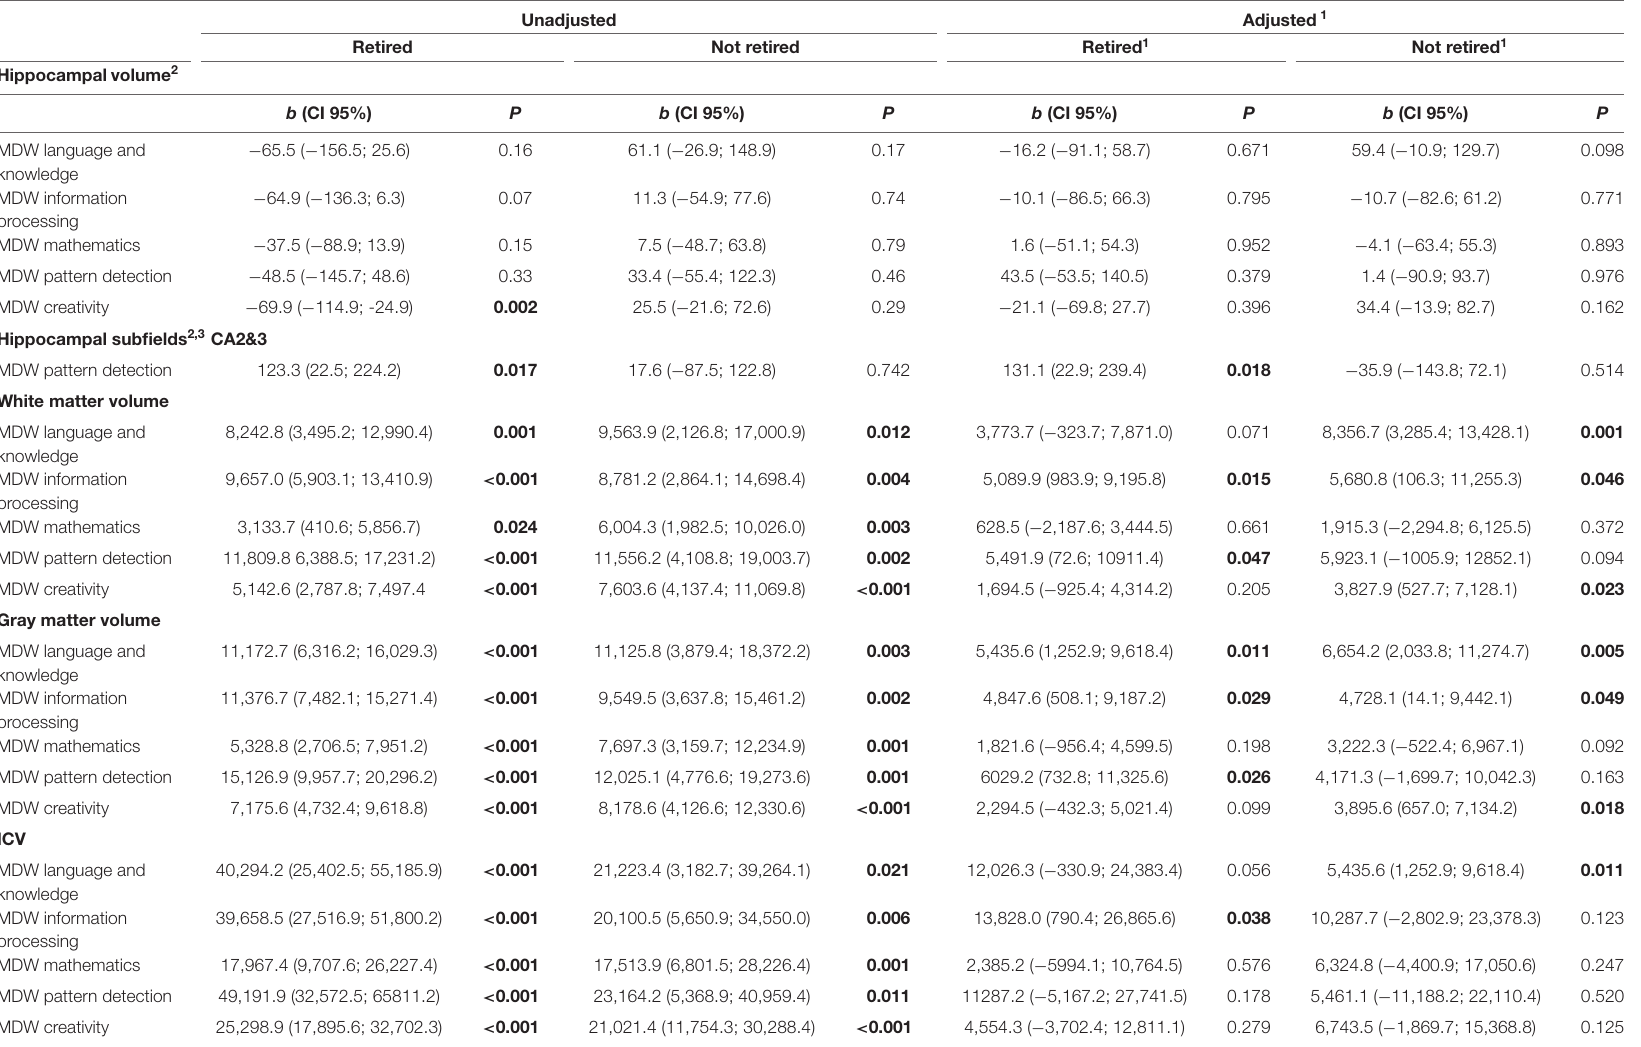
TABLE 4 | Results of the regression analyses on the association between MDW and hippocampal and brain volume, separate for those that are retired and those that are not retired, adjusted for age, gender, education, APOE e4-allele, hypertension, and diabetes. Unadjusted Adjusted 1 Retired Not retired Retired 1 Not retired